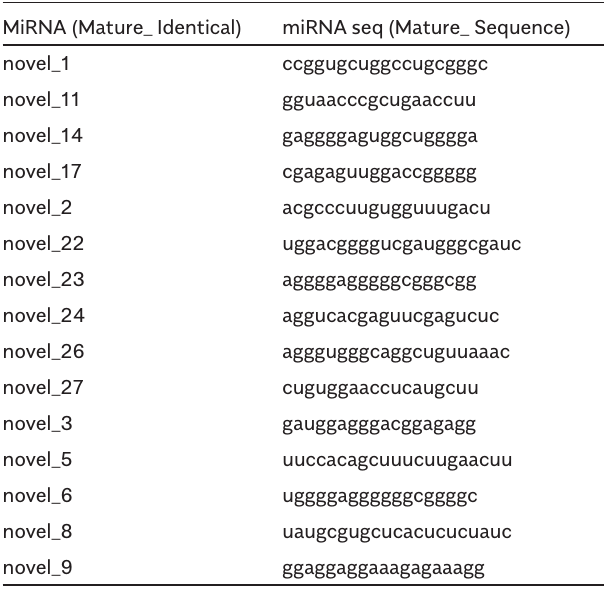
Table 2. Mature MiRNA Sequences Isolated from Coffee EPDENs MiRNA (Mature_ Identical) miRNA seq (Mature_ Sequence)